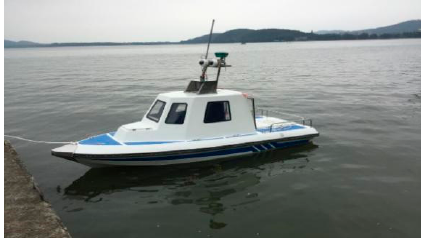
Figure 11. The iNav-II USV.